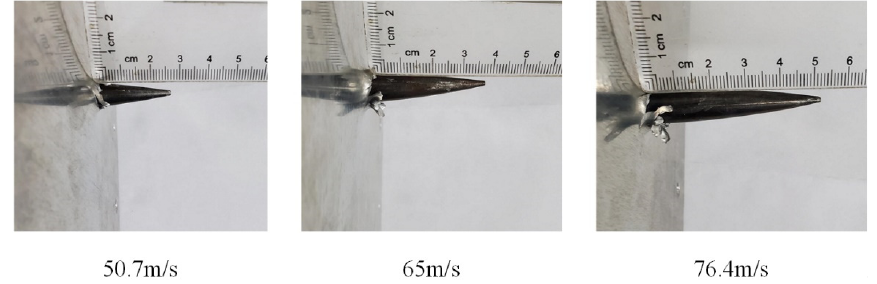
Figure 6. Experimental results.